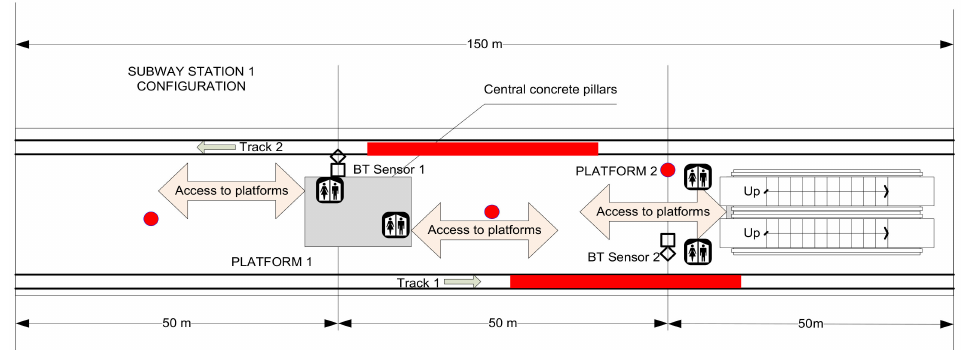
Figure 1. Aspect of Station 1 test bed setup (red dots representing placement of human observers).